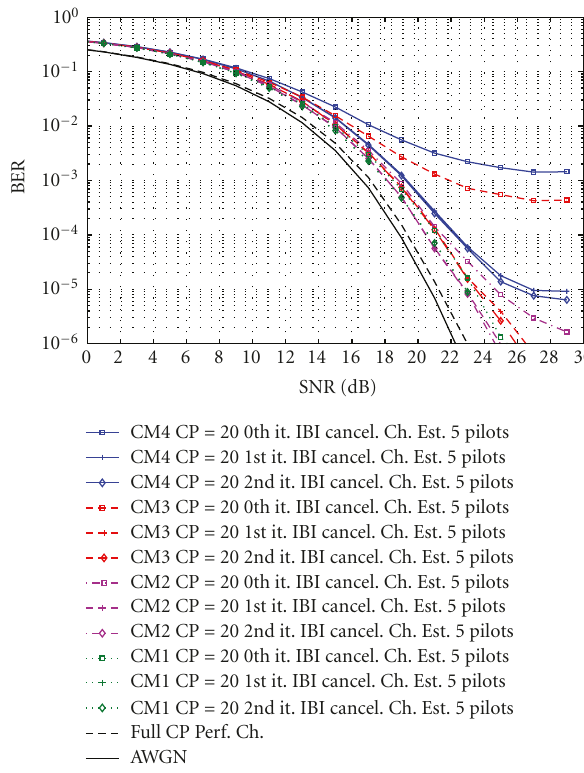
Figure 4: Receiver performance over di ff erent channel models, for CP = 20 and channel estimation with 5 pilot blocks.